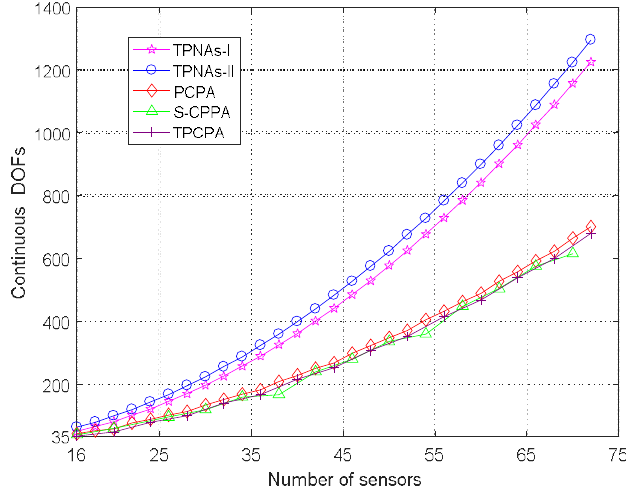
Figure 4. Continuous DOFs comparison for five kinds of physical array configurations.